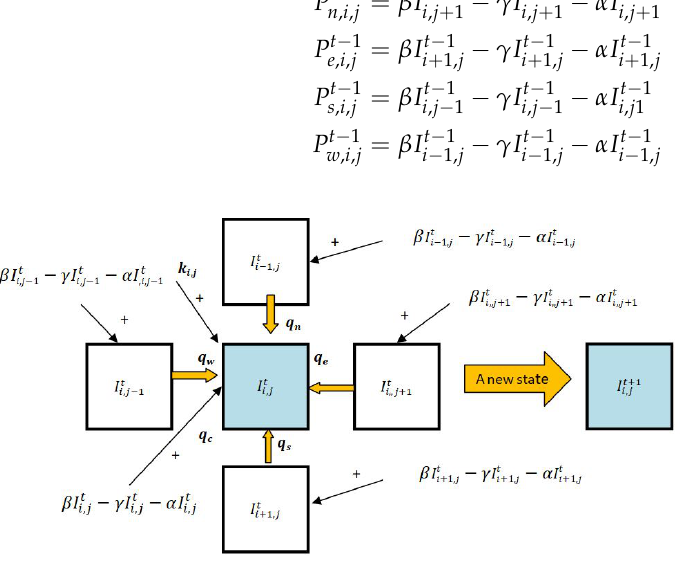
Figure 4. The state transition N-CCA diagram